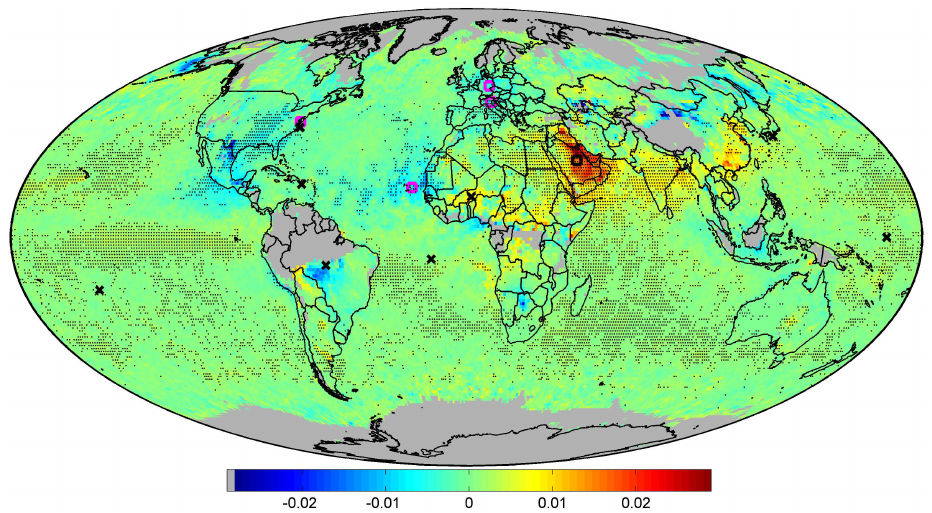
Fig. 8. Linear trend based upon deseasonalised monthly anomaly of AOD at 550nm for the period 1998–2010. Units are AODyr − 1 . Dots indicate significance at 95% confidence level. The black and pink boxes and symbol (x) represent the ground based AERONET locations with AOD tendency of positive, negative, and statistically insignificant values, respectively. Regions shaded in grey indicate no data or insufficient sample size for trend